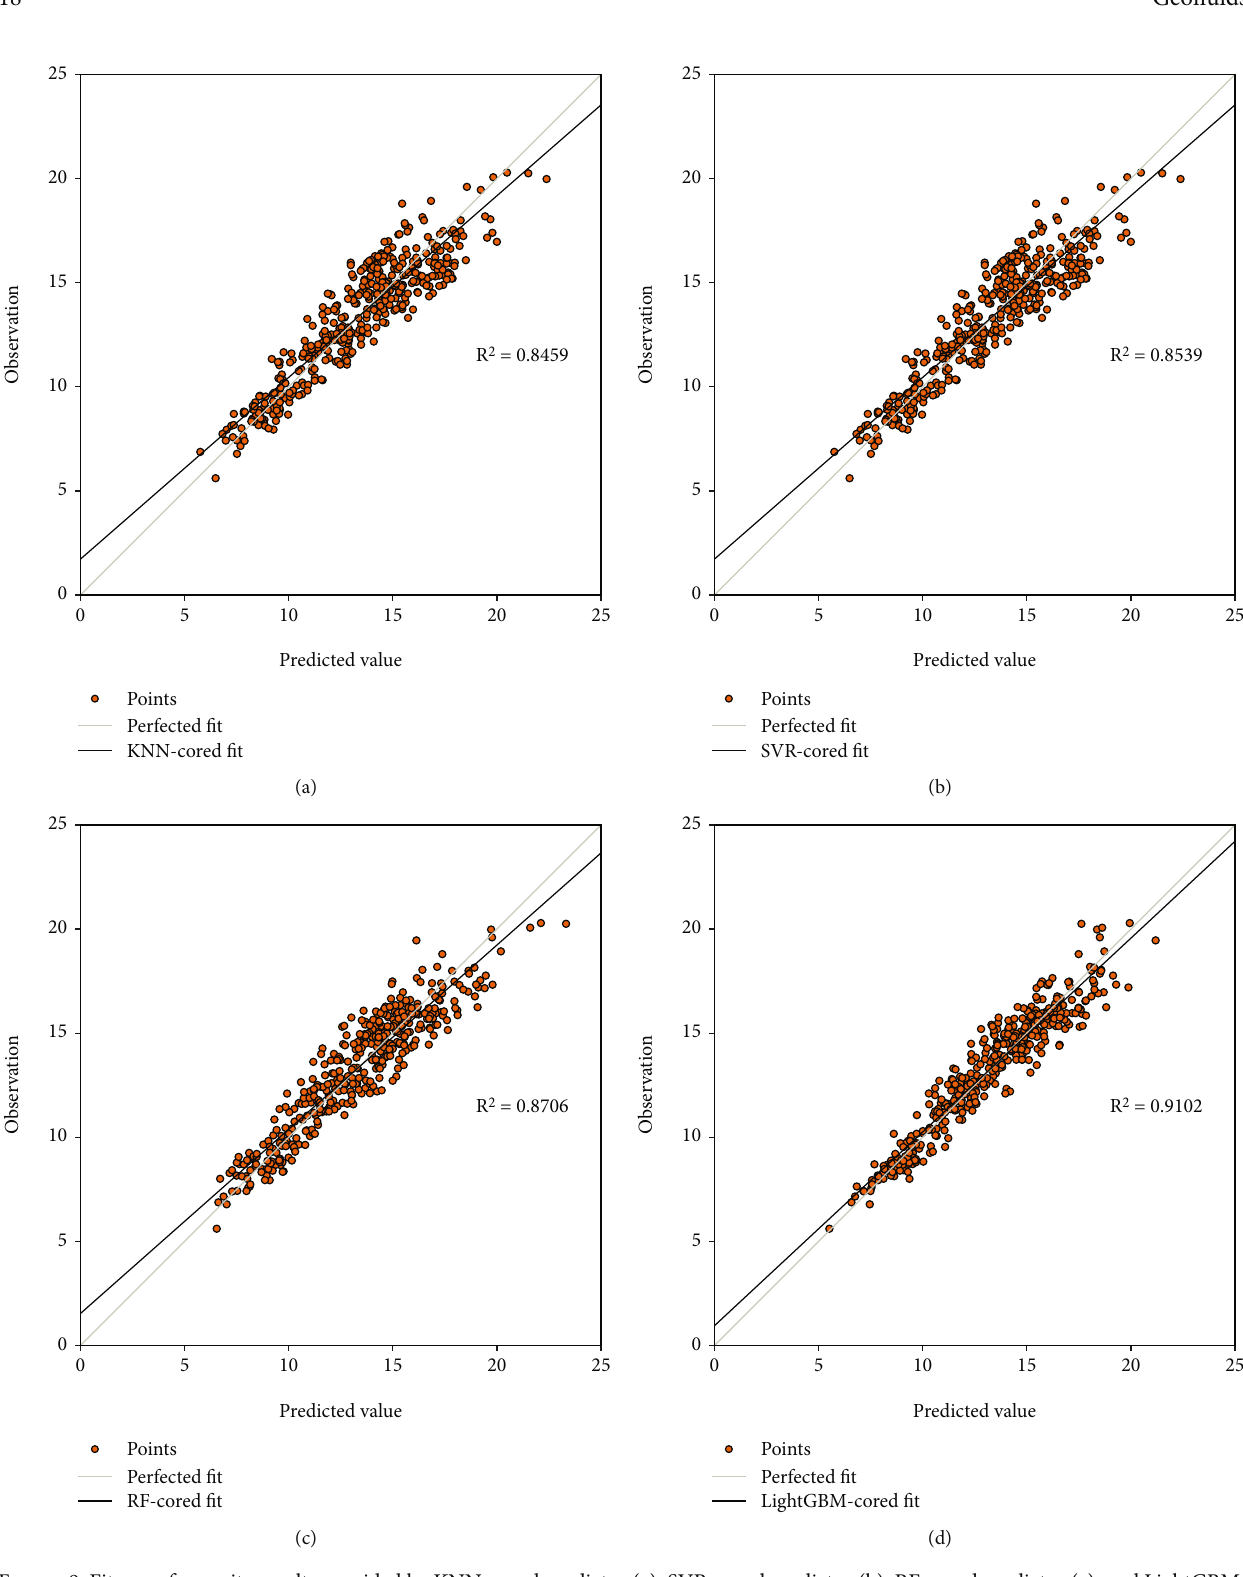
Figure 9: Fitness of porosity results provided by KNN-cored predictor (a), SVR-cored predictor (b), RF-cored predictor (c), and LightGBM- cored predictor (d) in the fi rst experiment. KNN =k-nearest neighbors; SVR =support vector regression; RF =random forest; LightGBM=light gradient boosting machine; RMSE =root-mean-square